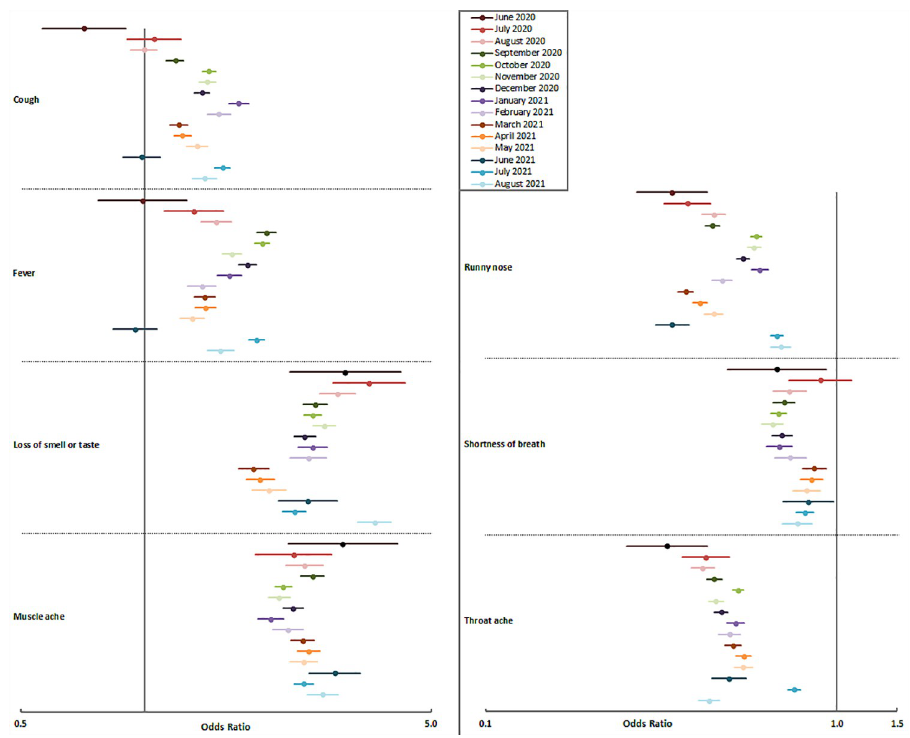
Fig 1. Odds ratios and 95% confidence intervals per variable in the full multivariable logistic regression model per month, from June 2020 through August 2021, the Amsterdam region, the Netherlands.